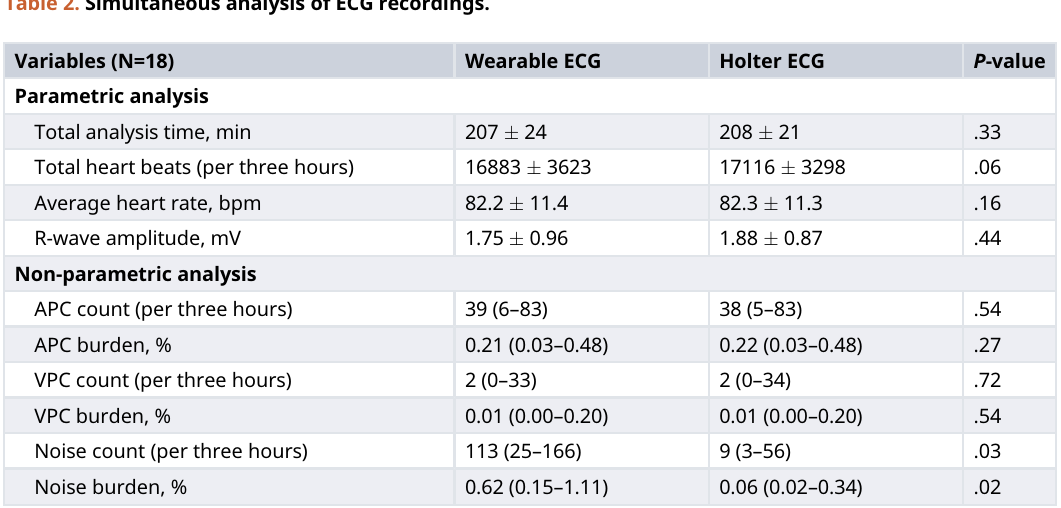
Table 2. Simultaneous analysis of ECG